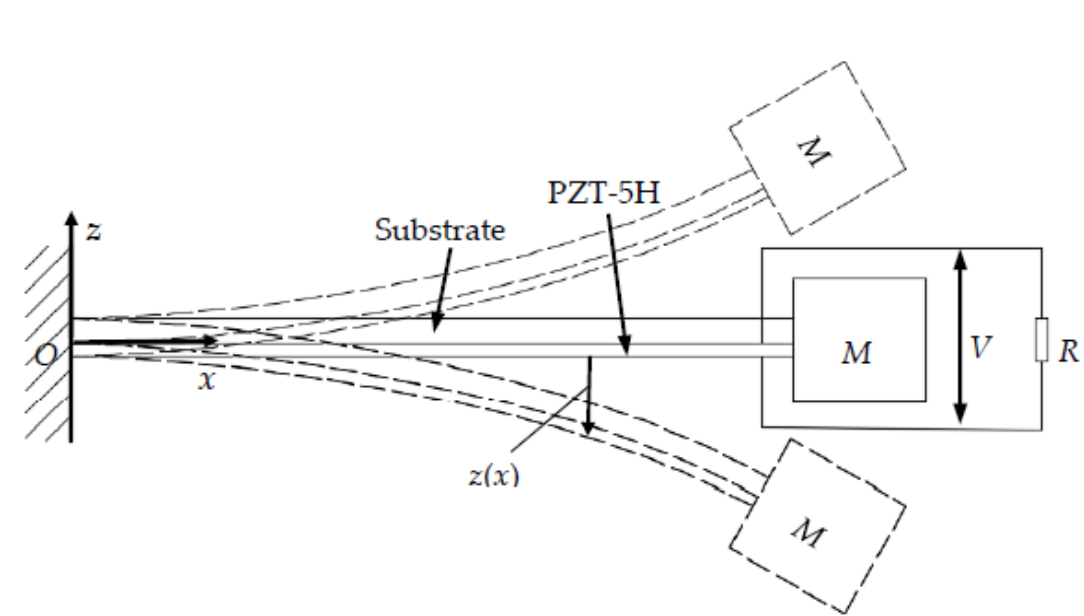
Figure 5. Electromechanical coupling model.